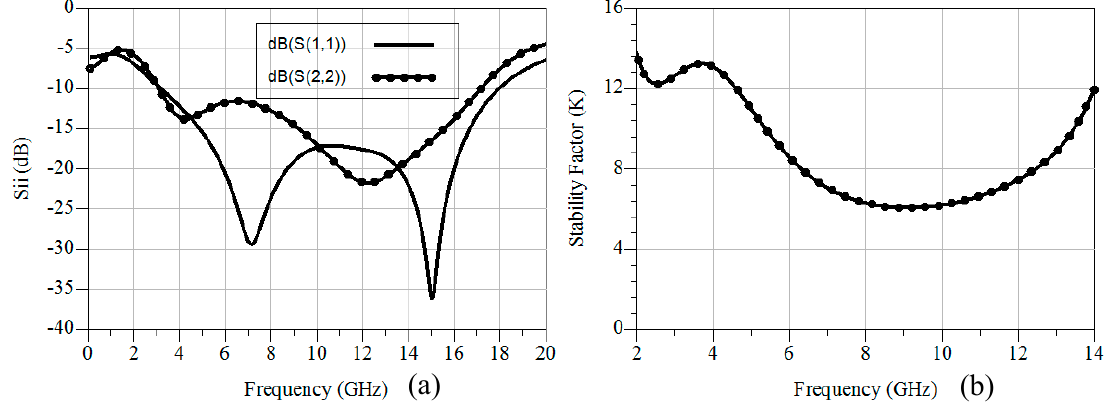
Figure 5. Simulated results of: ( a ) input / output reflection coe ffi cients and, ( b ) LNA Stability.